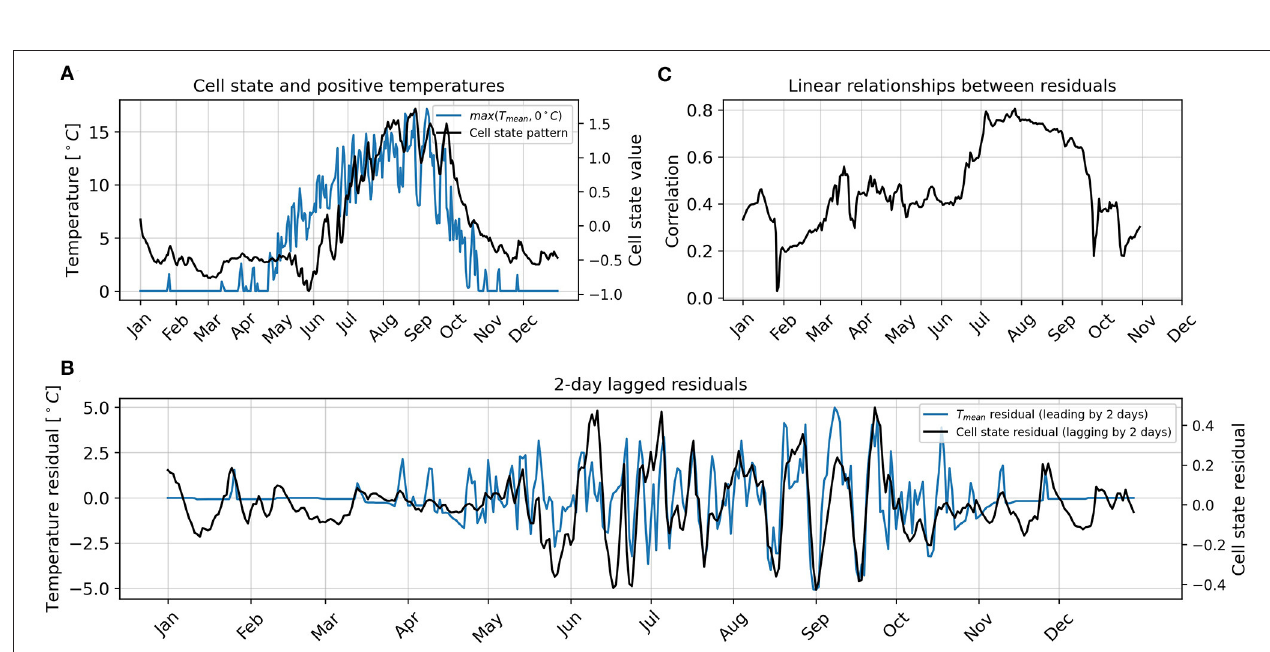
FIGURE 8 | The representation of glacier runoff in LSTM cell states. (A) Positive mean daily temperatures, calculated as an average over the central region, and the mean cell state pattern of the glacier-runoff-like set of cell states. (B) The lagged residuals of mean temperature and the cell state pattern, as calculated by removing the 30-day running mean of each time series in (A) . (C) The correlation between temperature residuals and 2-day-lagged cell state residuals for each 60-day running window through the year.